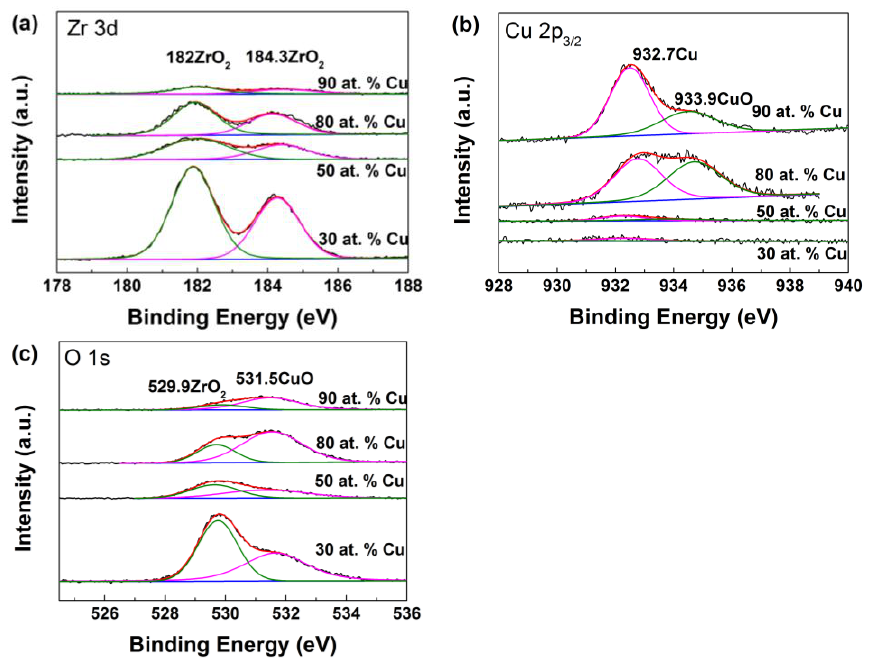
Figure 7. X-ray photoelectron spectroscopy (XPS) spectra of the Zr-Cu glassy coatings after immersion in 0.01 M deaerated H 2 SO 4 solution for 16 h at ambient temperature; ( a ) Zr 3 d ; ( b ) Cu 2 p 3/2 ; ( c ) O 1 s .